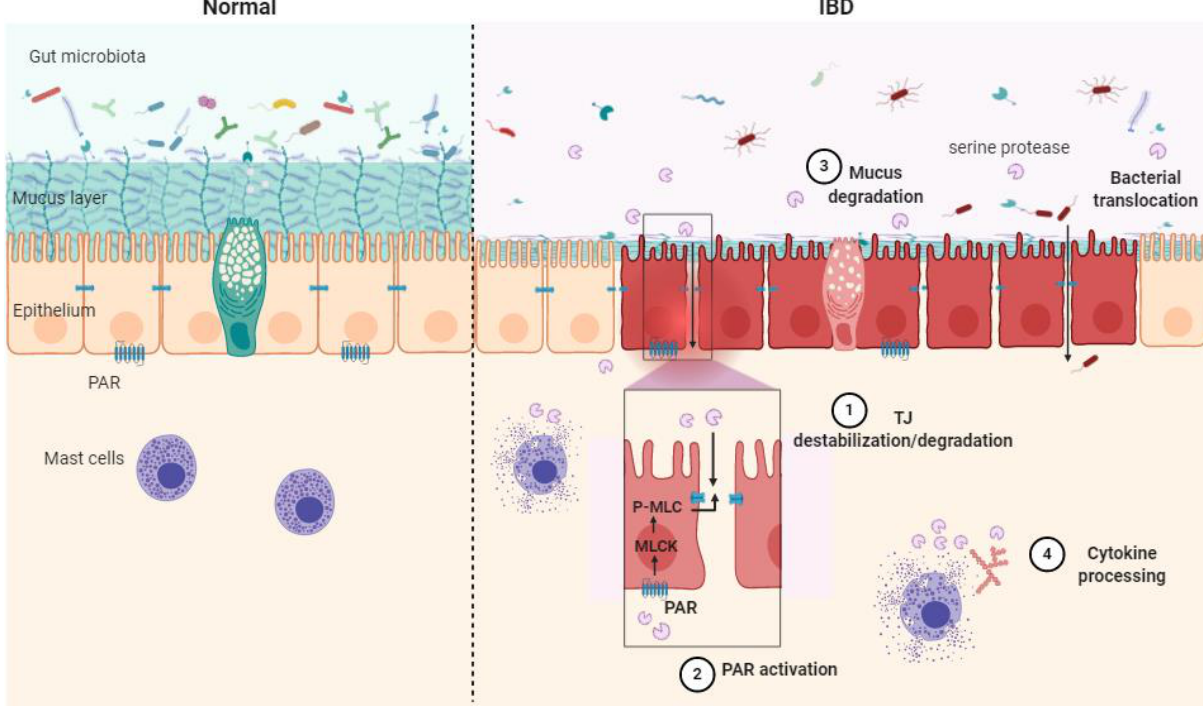
Figure 2. Schematic illustration of the serine protease mode of action in healthy context ( Normal ) and in inflammatory bowel disease ( IBD ) pathology. Epithelial barrier impairment is associated with serine protease action on the tight junction through direct cleavage. ( 1 ) Indirect destabilization deriving from protease-activated receptor (PAR) activation ( 2 ), mucus degradation ( 3 ) and cytokine processing ( 4 ). MLC: myosin light-chain, P-MLC: phosphorylated MLC, MLCK: myosin light-chain kinase, PAR: protease-activated receptor, TJ: tight junction.